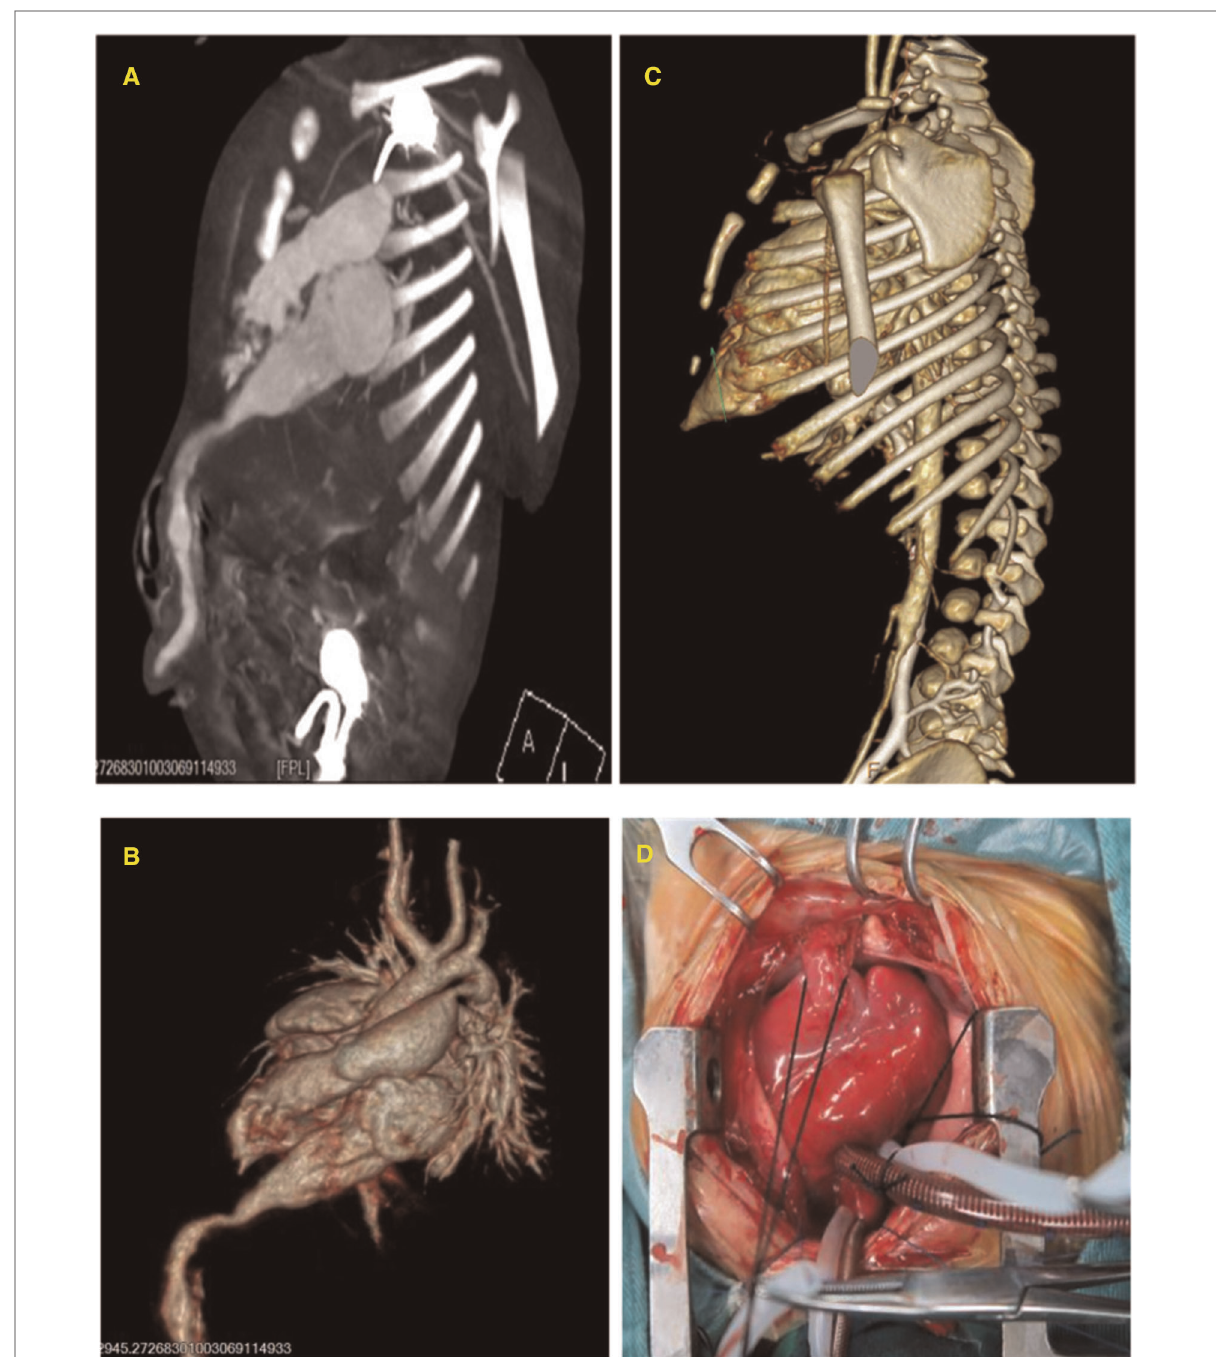
FIGURE 2 ( A ) Length of the ventricular diverticulum and narrowed neck connected to the left ventricle. ( B ) Three-dimensional reconstruction of the left ventricular diverticulum. ( C ) Partial defect of the lower sternum on computer tomographic angiography (CTA) (arrow). ( D ) Left ventricular diverticulum seen during